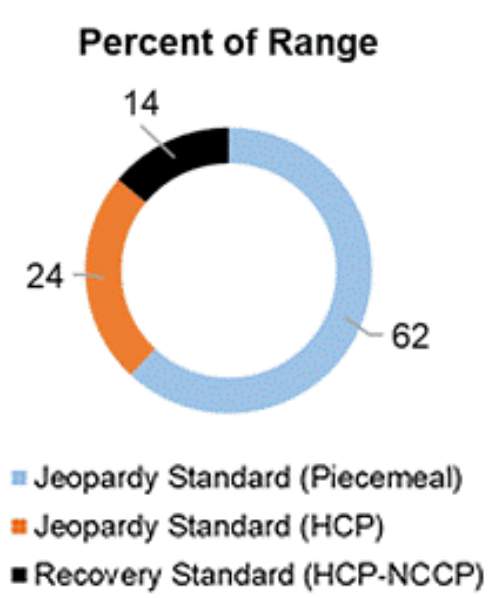
Fig. 4 . Percentages of each (minimal) conservation standard over the entire geographic range of the giant garter snake ( Thamnophis gigas